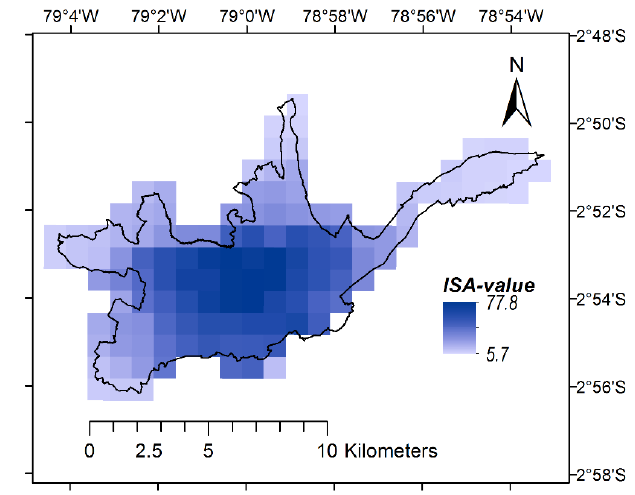
Figure 2. Impervious Surface Area (ISA)—30 arc-sec grid for Cuenca City.